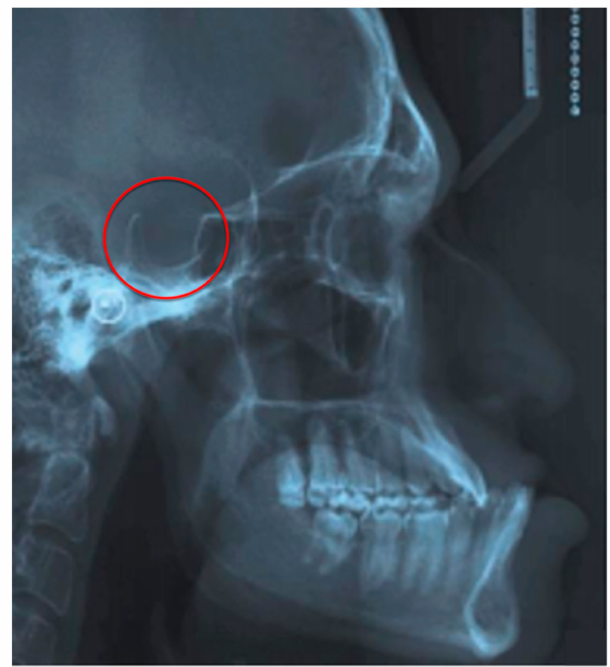
Figure 3. Cephalometric characteristics of a patient affected by acromegaly. Note the significant enlargement of sella